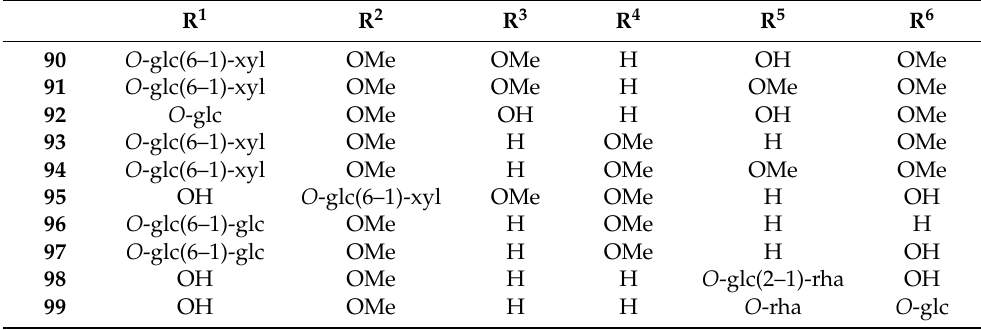
Table 3. The structure of compounds 90 – 99